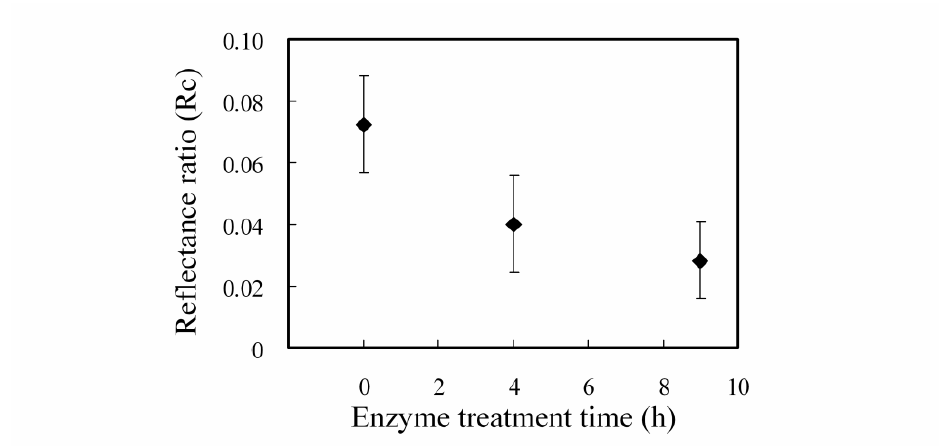
Fig. 4 Changes in reflectance ratio of an ultrasound echo before (0 h), after 4 hours (4 h), and after 9 hours (9 h) of collagenase digestion. Mean values (SD) are shown for the 0 h (n=10), 4 h (n=10), and 9 h (n=10) groups.